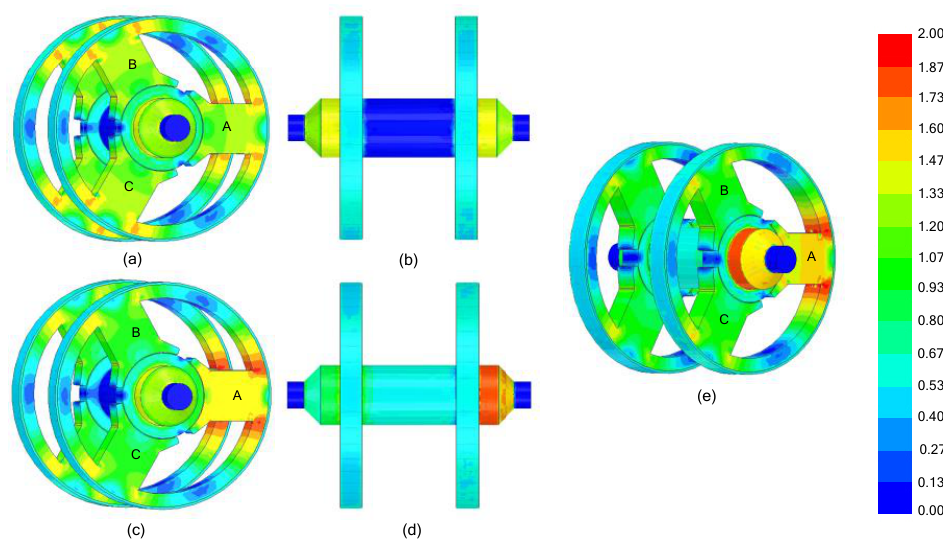
Figure 5. Magnetic flux density diagram: ( a ) radial bias fluxes, ( b ) axial bias fluxes, ( c ) radial fluxes, ( d ) axial fluxes, and ( e ) resultant fluxes.